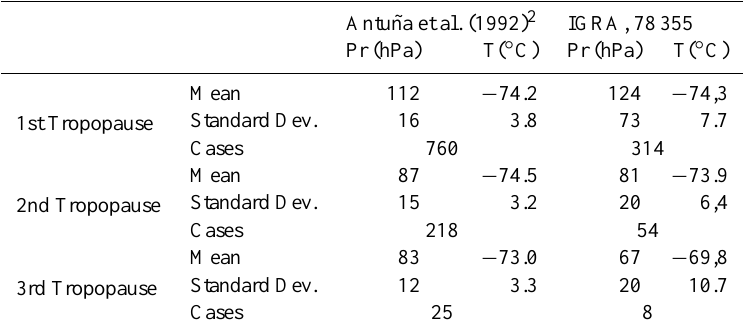
Table 2. Statistics for the multiple tropopause reports at Camag¨uey radio-sounding station (WMO number 78355) derived from original handwritten reports and from the current IGRA